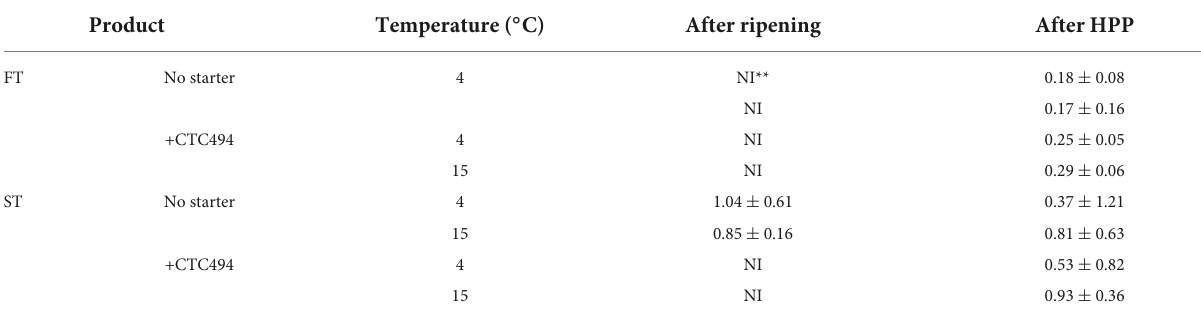
TABLE 1 Inactivation (Log 10 reduction) of L. monocytogenes due to the application of the corrective storage (7 days) at 4 and 15 ◦ C after ripening and after a HPP treatment at the end of ripening of fuet -type (FT) and snack-type (ST) chicken sausages spontaneously fermented (no starter) and with the addition of the bioprotective (sakacin K)-producing Latilactobacillus sakei CTC494.